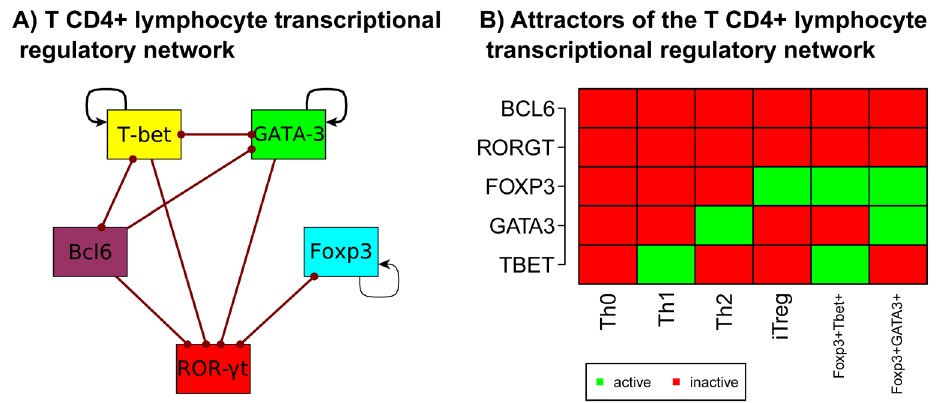
Fig 2. Minimal network of master transcriptional regulators CD4+ T (CD4+ T TRN). Based on published experimental data we constructed a CD4+ T cell regulatory network that includes the master transcriptional regulators and the interactions among those regulators (CD4+ T TRN). (A) Graph of the CD4+ T TRN. Node colors correspond to cell types: Th1 (yellow), Th2 (green), Th17 (red), iTreg (blue) and Tfh (purple). Activations among elements are represented with black arrows and inhibitions with red dotted arrows. (B) Attractors of the CD4+ T TRN: Each column corresponds to an attractor. Each node can be active (green) or inactive (red). The attractors correspond to configurations that characterize the Th0, Th1, Th2, iTreg, T-bet +Foxp3+ and GATA3+Foxp3+ types. The attractors corresponding to the Th17 and Tfh types could not be